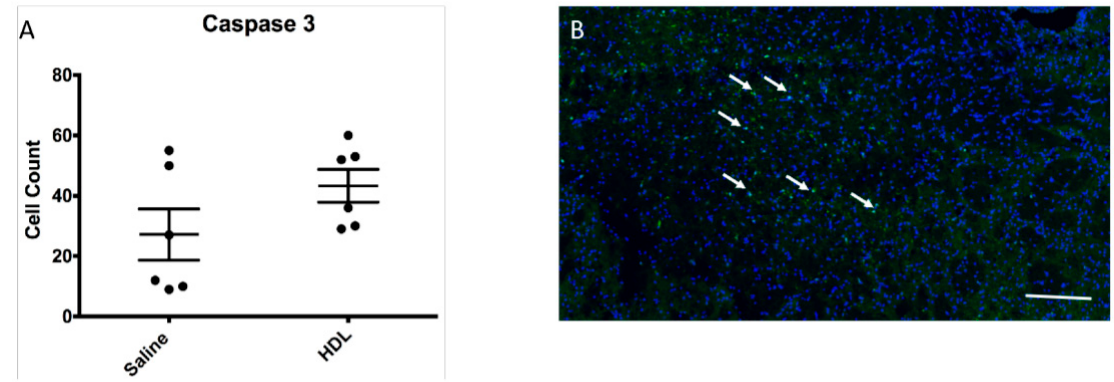
Figure 5. Apoptosis in infarct area. ( A ) Mean number of cleaved caspase 3 positive cells in selected field of infarcted brain. Saline: n = 6, HDL n = 6. ( B ) The white arrows show positive cleaved caspase 3 positive cells (green). Cell nuclei are stained with DAPI (blue). Bar = 80 µm for low magnification picture.